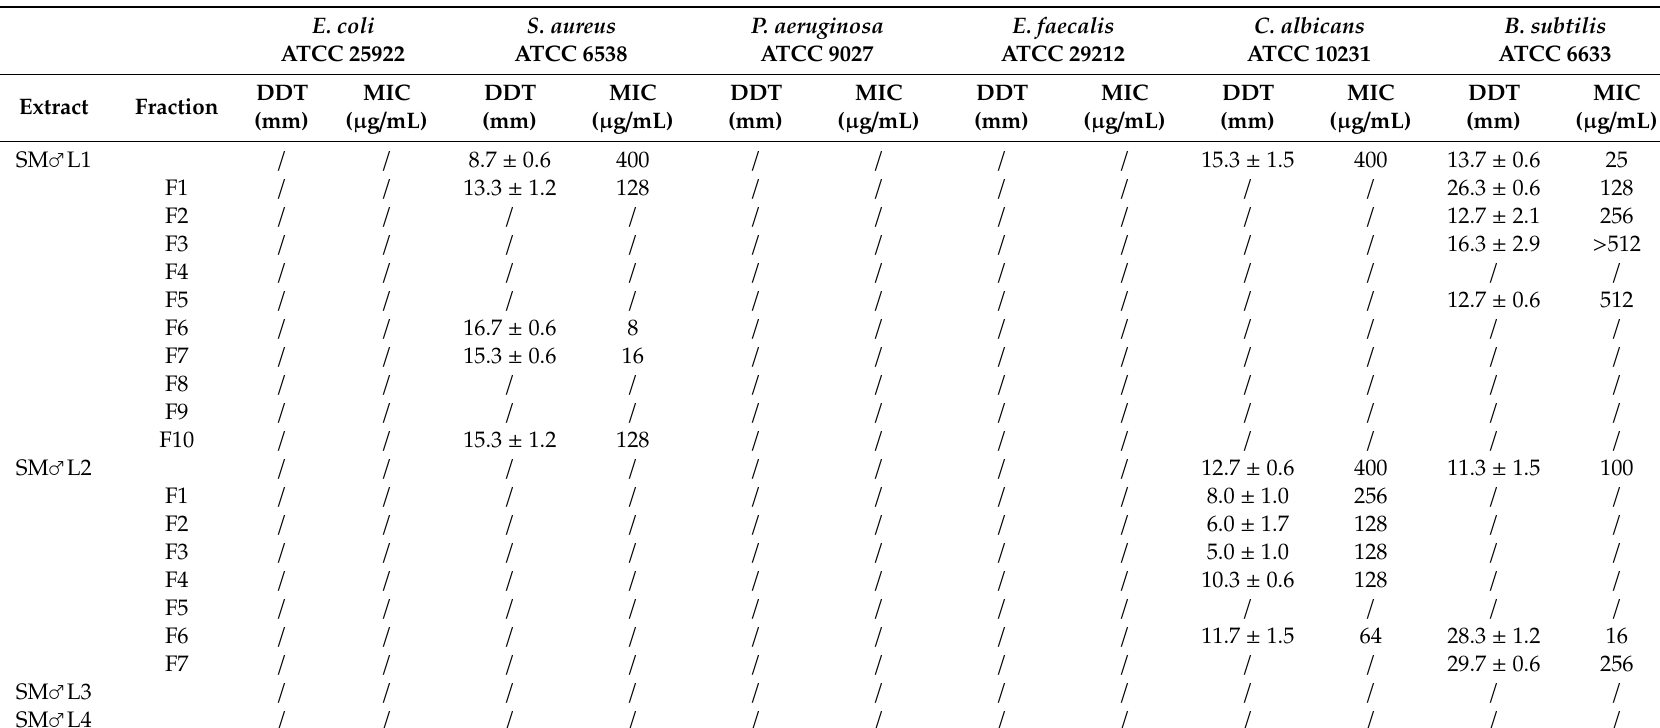
Table 2. Disk Di ff usion Test (DDT) and Minimal Inhibitory Concentration (MIC) of S.molle (L.) leaf (from male plants), extracts and fractions ( p values ≤